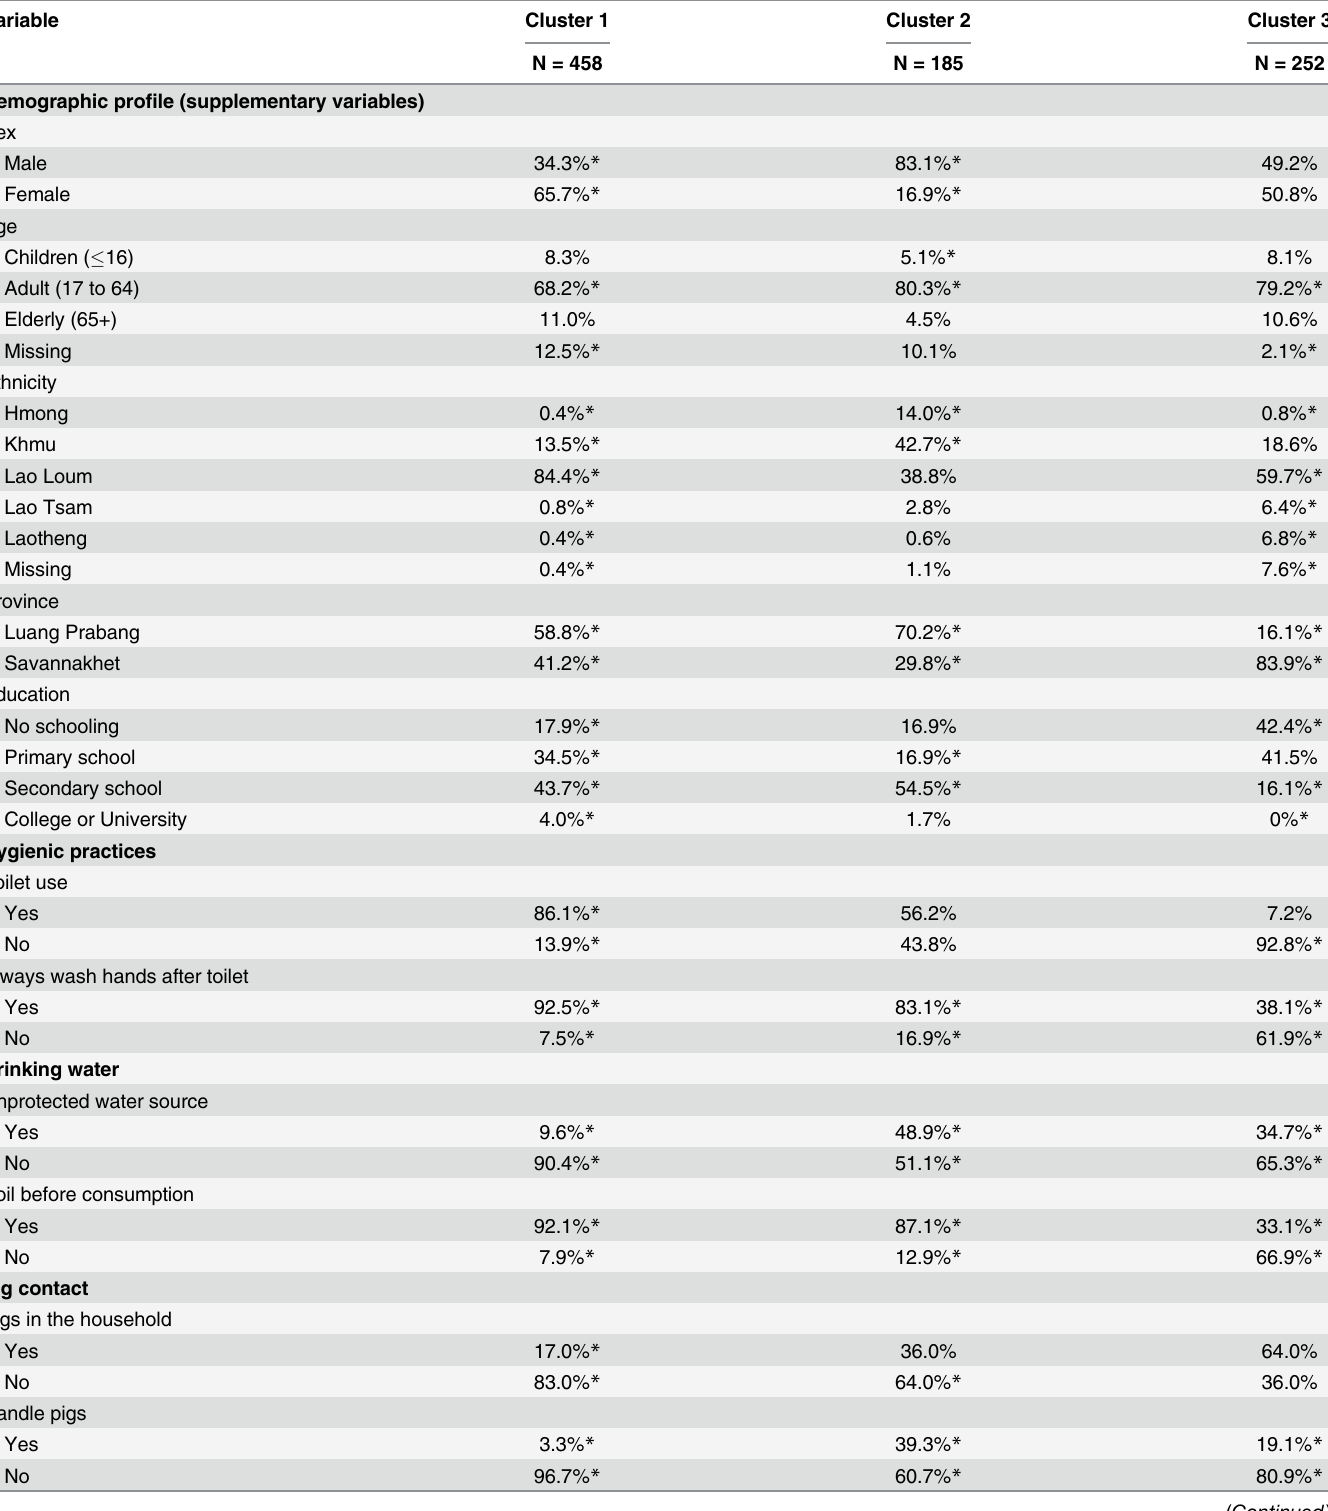
Table 2. Description of the three typologies identified using MCA and HCA and allocation of all surveyed individuals, N = 895 ( * denotes categories which exhibited differences between clusters with a p-value (cid:1) 0.05).